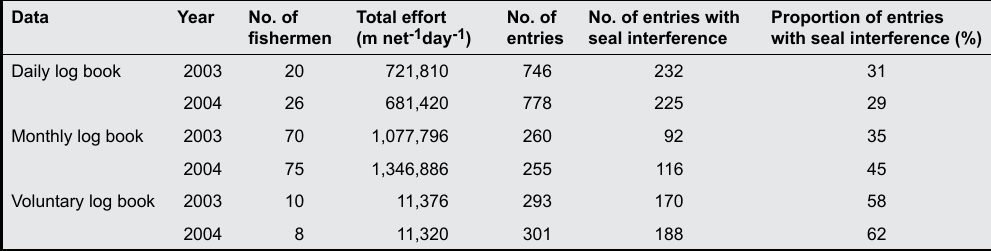
Table 1. The numbers of fishermen, logbook entries and records of seal interference for the herring gillnet fishery, in the EU official logbook and in the voluntary logbook. Data Year No. of